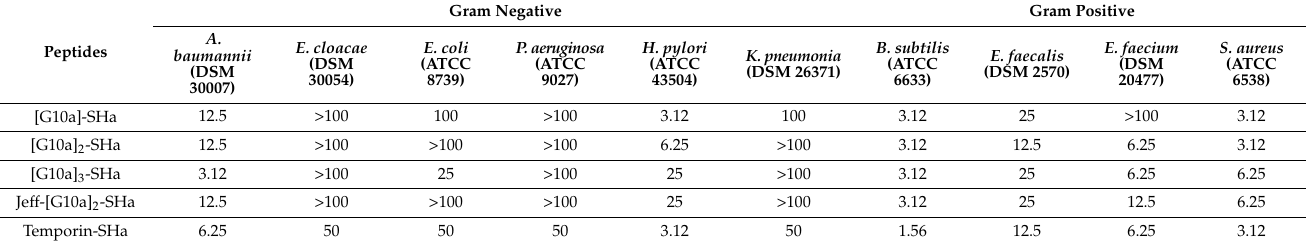
Table 4. Antibacterial activity of dendrimers on various Gram-negative and Gram–positive bacteria. Antibacterial activity of the dendrimers is expressed as minimal inhibitory concentration (or MIC) in µ M. Gram Negative Gram Peptides